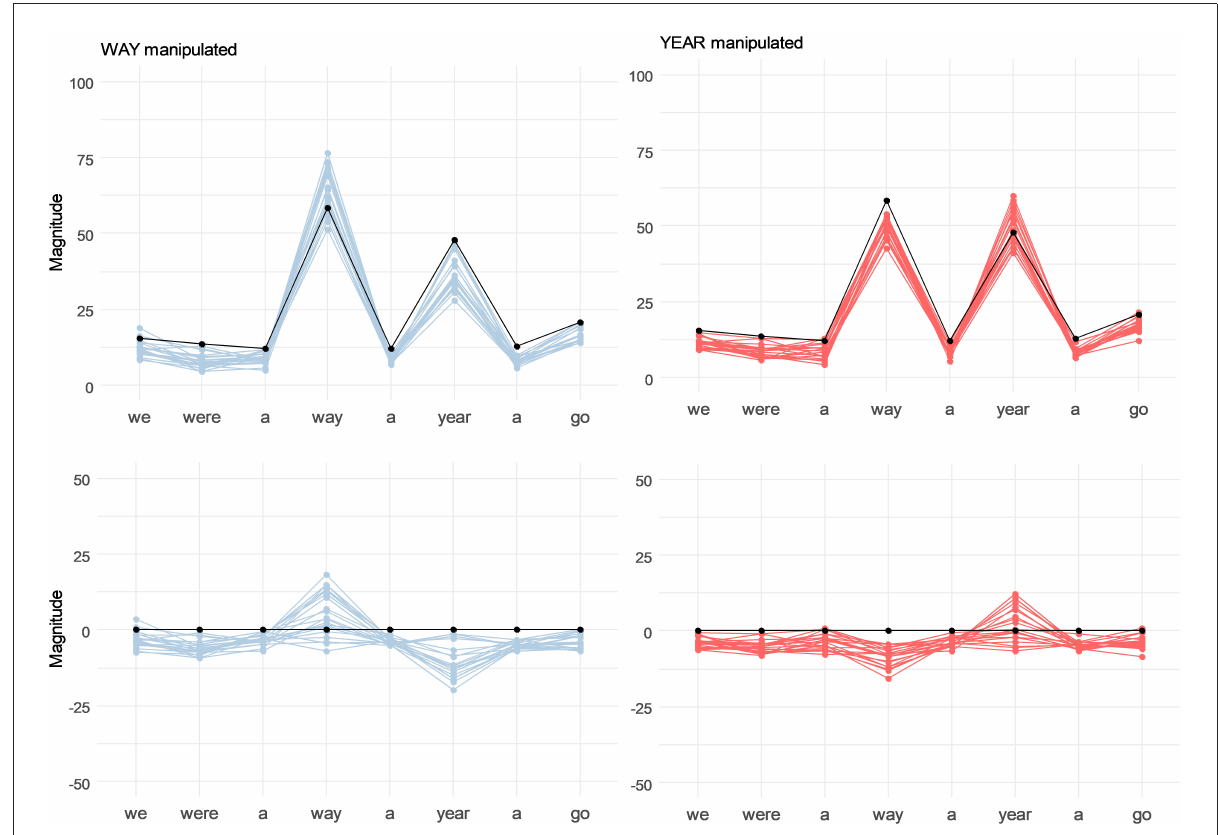
FIGURE7 Perceived prominence of all syllables in synthetic stimuli in Test 2. (Top panels) The contours for individual stimuli averaged across participants; baseline stimulus is shown in black. (Bottom panels) Same contours normalized to the